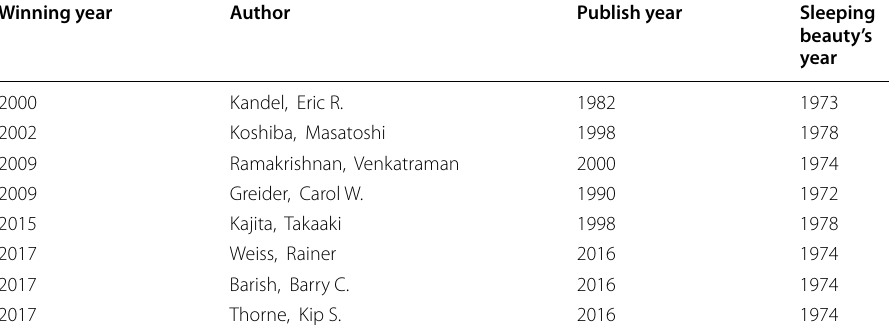
Table 8 Prize winning authors of